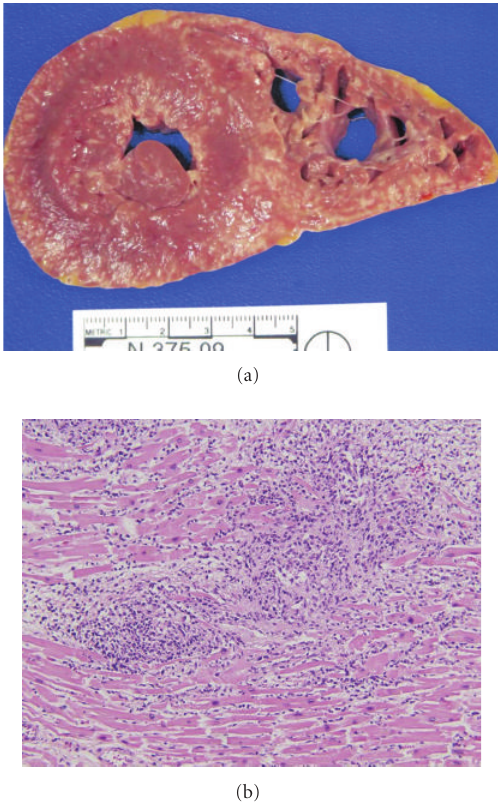
Figure 2: Gross and microscopic appearance of heart. Cross- section of heart, left, demonstrating extensive tan-yellow marbling of the myocardium due to infiltration by histiocytes. Microscopic appearance of heart, right. There was dense proliferation of histiocytes within the myocardium similar to that seen in the lymph node. Hematoxylin and eosin, 100x